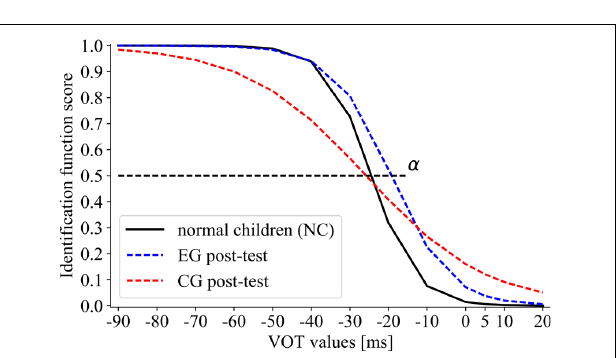
FIGURE 8 | The sigmoid function for post-test performance of EG and CG subgroups in comparison to NC. The boundary location ( α ) corresponds to the VOT value at which 50% of voiced/unvoiced identifications were